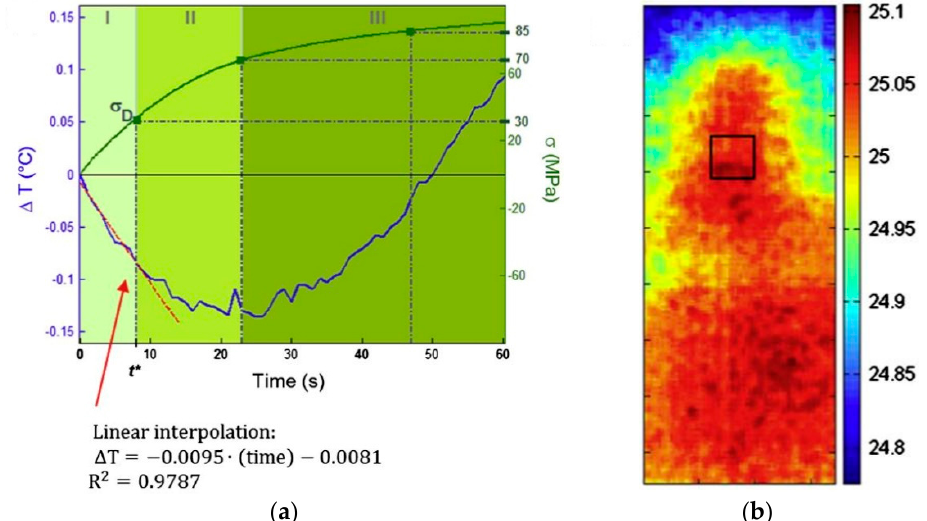
Figure 7. ( a ) Temperature trend and stress trend of the [+45°, − 45°] s specimen. Deviation from linearity indicates the damage onset, specifically at time t* and stress σ D ; ( b ) thermal map of the specimen at t*. The black box is the region where the average temperature is calculated